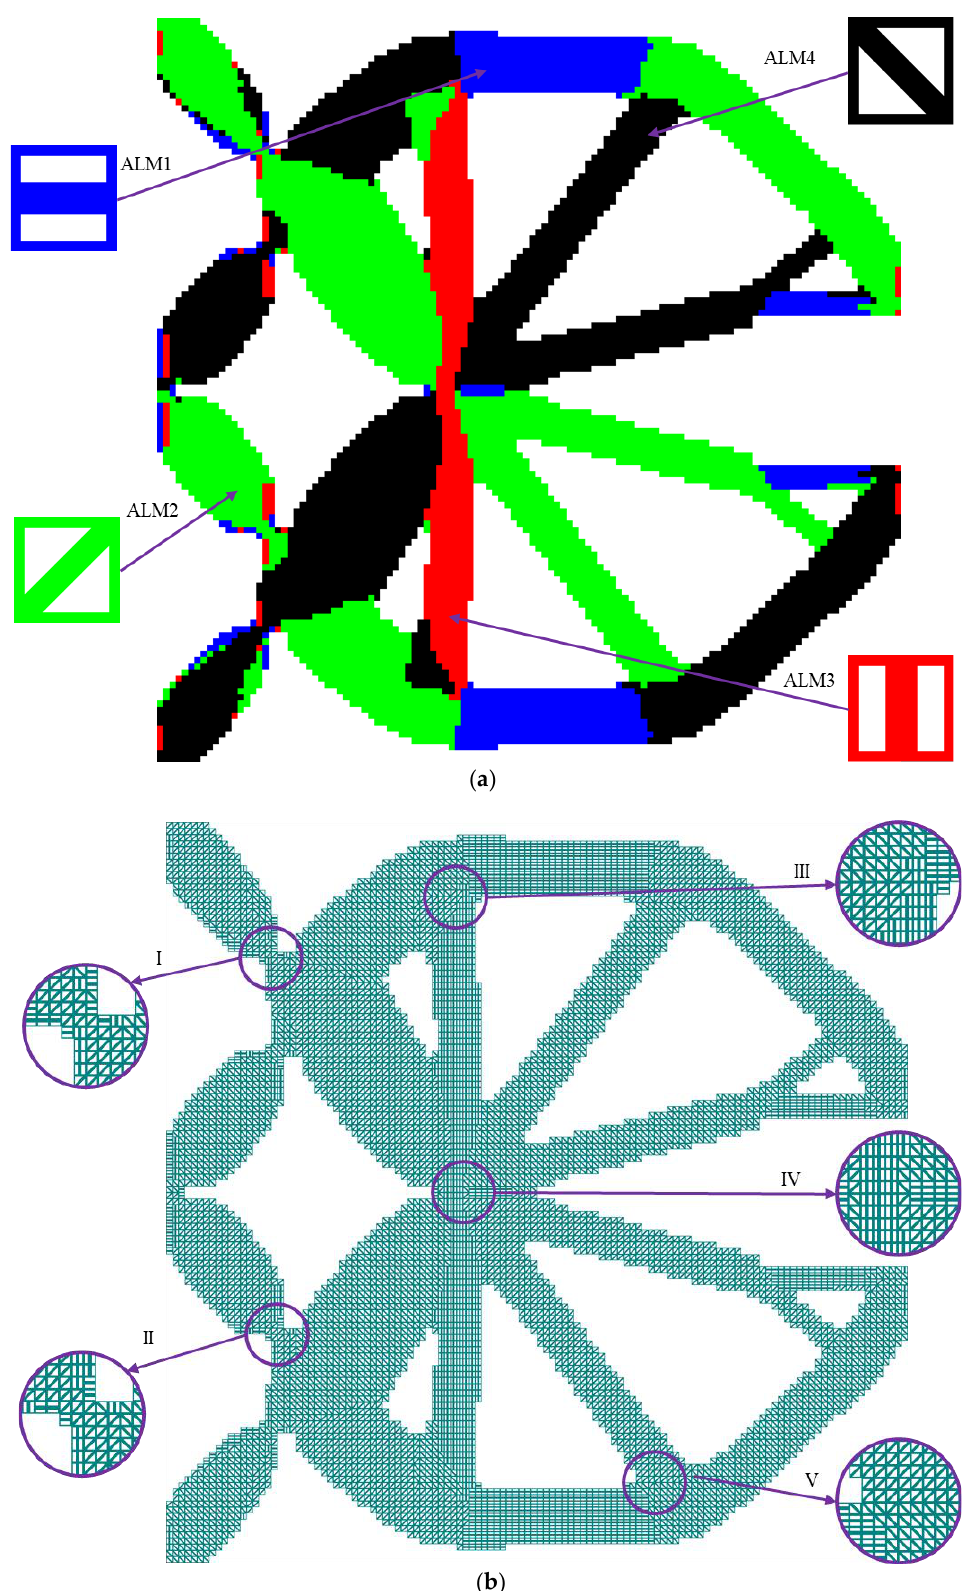
Figure 13. Optimized result with ALMs for the CGM: ( a ) layout of different ALMs; ( b ) optimized anisotropic HL-CGM with partial enlargement areas I, II, III, IV and V. Moreover, a traditional optimized CGM with only solid material is designed for com- parison with the abovementioned HL-CGMs with OLMs and ALMs by constraining the equal volume fractions. The optimized solid CGM is displayed in Figure 14. The objective output displacements acquired by the solid CGM are inferior compared with the HL- CGMs with OLMs and ALMs, as exhibited in Figure 15. The optimized HL-CGMs with OLMs or ALMs in Figures 11 and 13 possess superior compliant effects with objective output displacements of 0.9366 and 1.1702, respectively. Their objective output displace- ments exceed those of the solid CGM by 21.42% and 51.70%, respectively. This example shows that the ALMs could make full use of constitutive materials, thereby significantly improving the compliant performance of the CGM based on the ICM method.